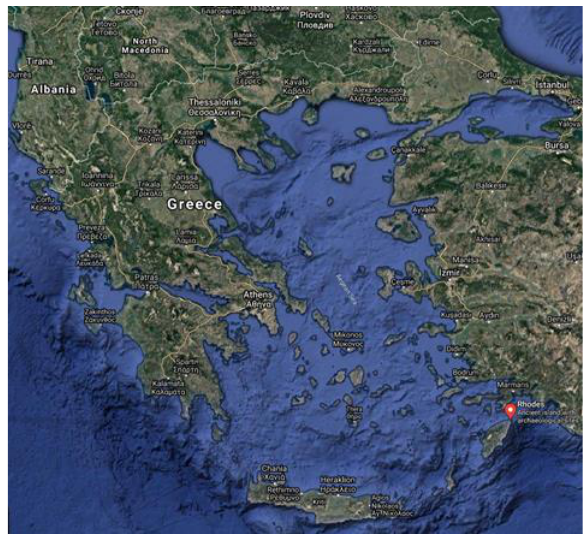
Figure 2 . Map of Greece and